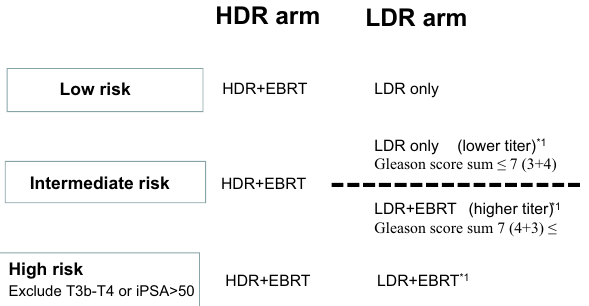
Figure 1. Patients selection criteria for Treatment scheme by risk factors. *1 = four patients received LDR + EBRT in lower titer of intermediate risk group, and seven patients received LDR only in higher titer of intermediate risk group, and two patients received LDR only in high